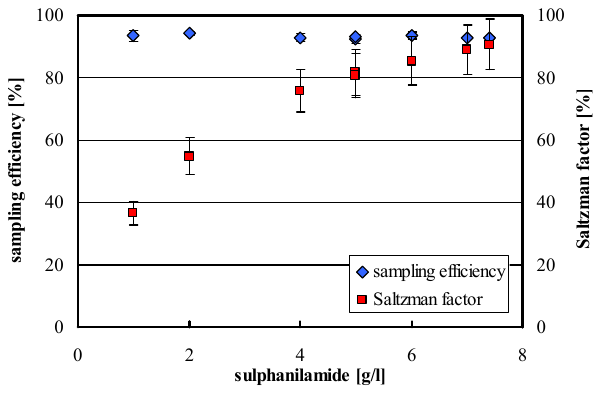
Fig. 4. Variation of the sampling efficiency and the Saltzman Variation of the sampling efficiency and the Saltzman factor with the factor with the sulphanilamide concentration. Griess-Saltzman sulphanilamide concentration. Griess-Saltzman Reagent: 1.6 g/l NEDA, pH = 3, Reagent: 1.6gl − 1 NEDA, pH=3, adjusted with NH 3 . Air adjusted with NH 3 . Air flow = 1000 ml/min, liquid flow = 0.2 ml/min. flow=1000mlmin − 1 , liquid flow=0.2mlmin − 1 .